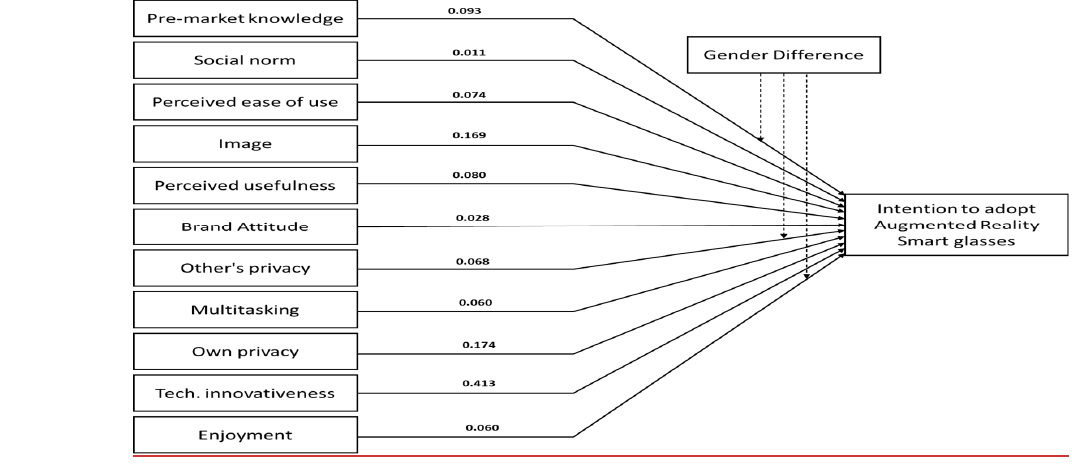
Fig. 9. Results of Testing Study theoretical